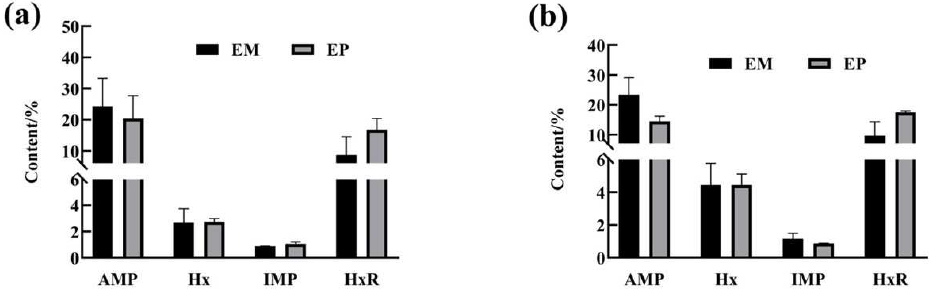
Figure 6. Comparison of nucleotide content in edible tissues of Chinese mitten crabs in the EM and EP groups: ( a ) female; ( b ) male.